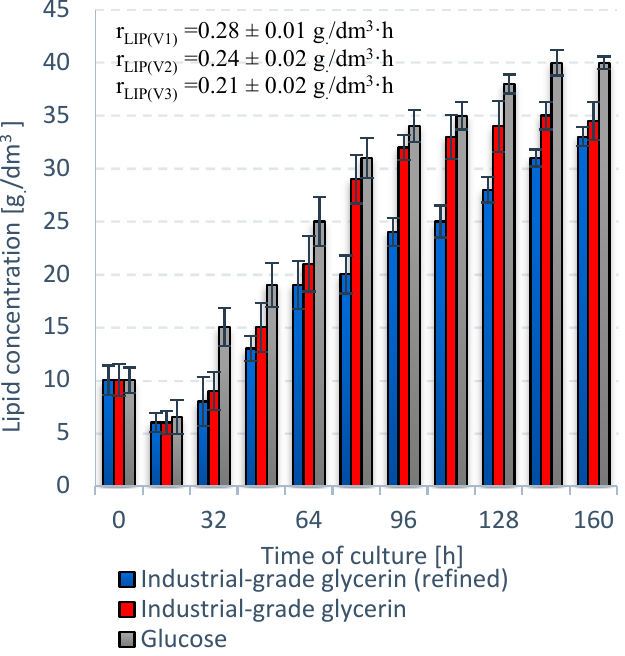
Figure 4. Trends in lipid content for S. limacinum E20 for different carbon sources. The highest r DW and r LIP were recorded for V1, reaching 0.62 ± 0.02 g DW /dm 3 ·h and 0.28 ± 0.01 g/dm 3 ·h, respectively (Figures 3 and 4). V2 produced higher rates of r DW and r LIP than the V3, with differences of ∆ r DW = 0.06 and ∆ r LIP = 0.03. Moreover, the dry weight (70.0 ± 0.1 g DW /dm 3 ) and lipid concentration (35.0 ± 0.3 g/dm 3 ) were higher in this variant (Figures 3 and 4). The S. limacinum strain is capable of growing and of lipid accumulation on various carbon sources. Yokochi et al. (1998) confirmed the ability of this microalgae to grow on nine different carbon sources, including glucose, fructose, and oleic acid. The highest biomass concentration, 16 g DM /dm 3 was obtained for oleic acid, while the highest DHA content 1.1 g/dm 3 , was observed for the glycerol-based medium. [30]. The cost of the carbon source such as glucose, is high compared to other nutrients (nitrogen, micronutrients) that must be added to the microalgae culture [31]. Thus, in order to increase the economic efficiency of the heterotrophic bio-oil production technology using microalgae, other, cheaper sources of carbon should be used. One of the proposed